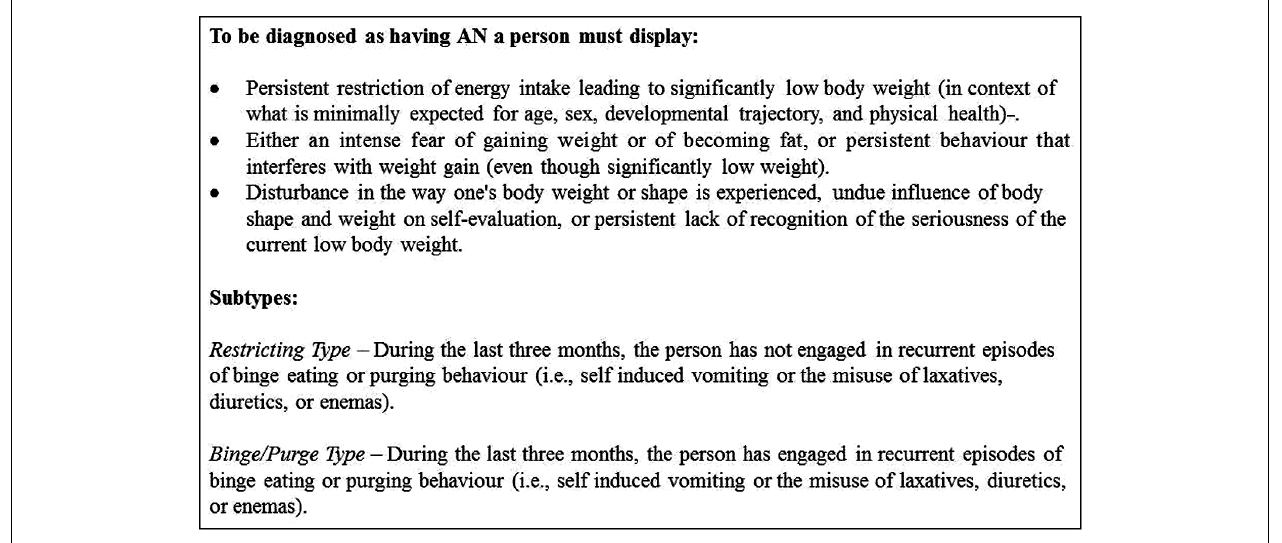
FIGURE 1 |The DSM-V diagnostic criteria for anorexia nervosa (American PsychiatricAssociation, 2013).